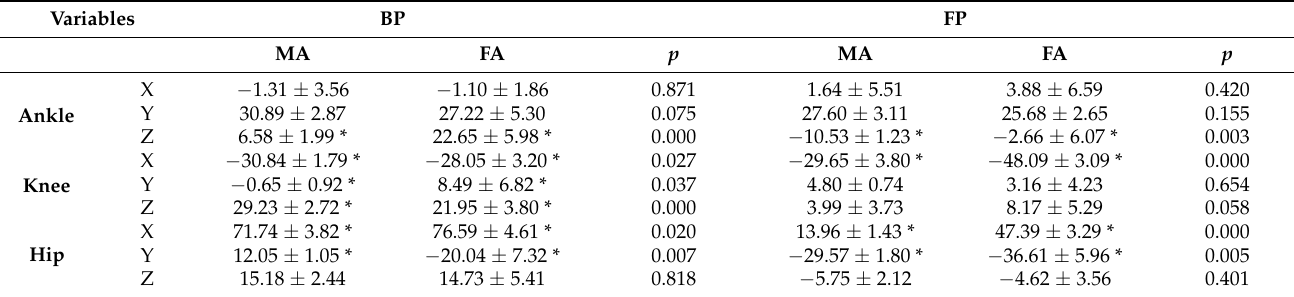
Table 3. Comparison of means ± standard deviations for joints angles during key events of the BP and FP between MA and FA (unit: